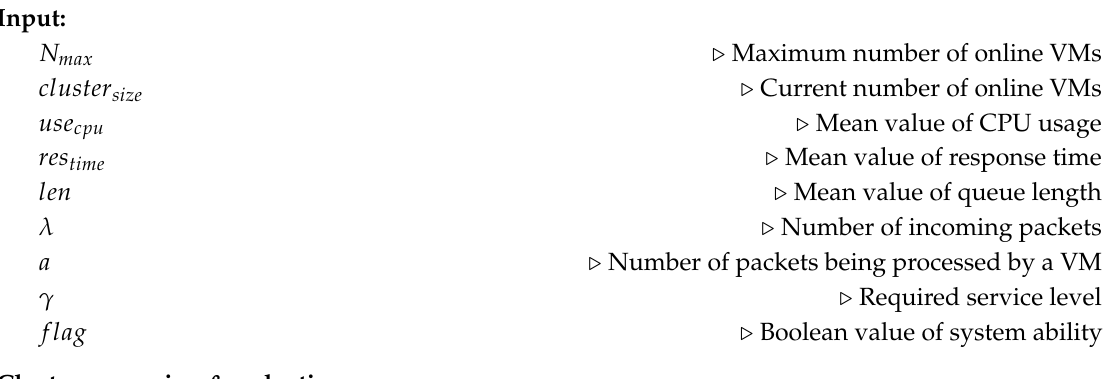
Algorithm 1 Cluster expansion and reduction